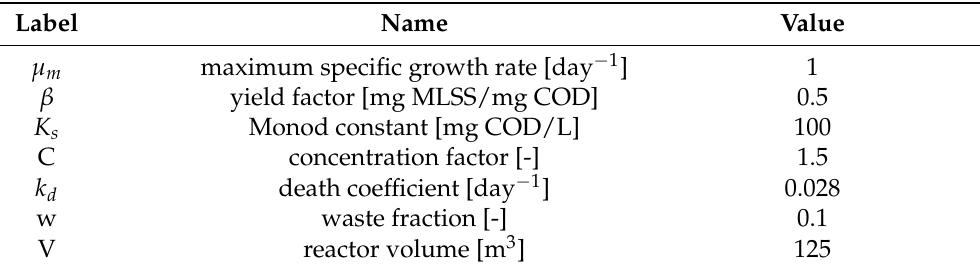
Table 1. Constant parameters of the model equations. We used the parameter values in [16]. The reactor volume used is from